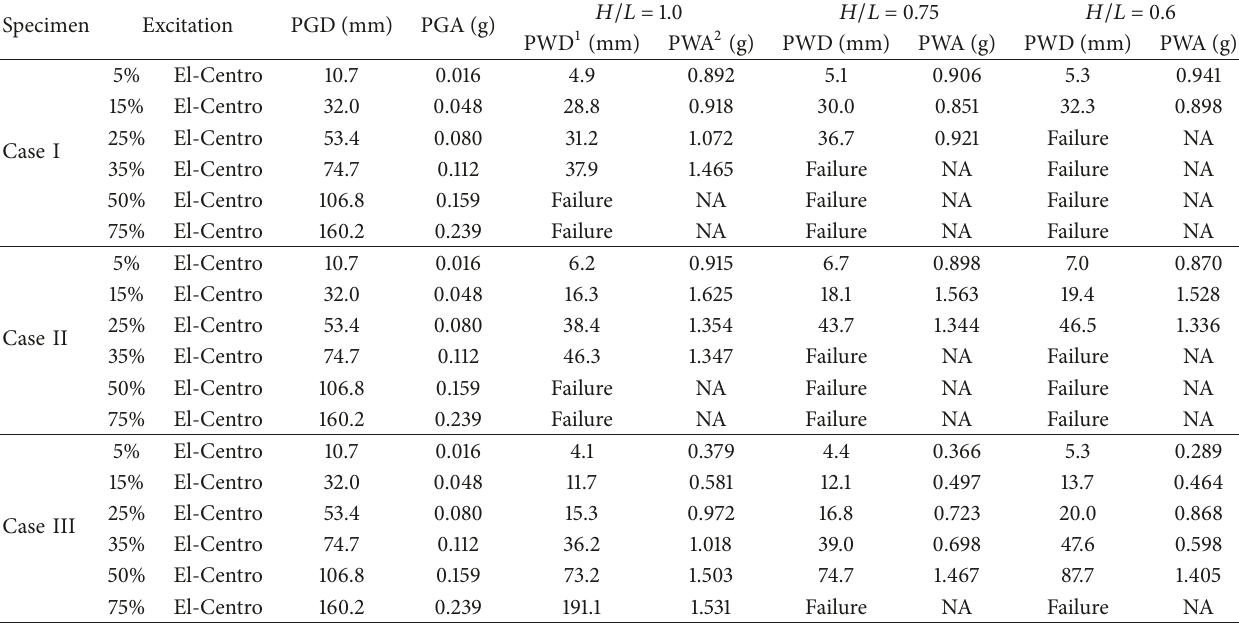
Table 4: Summary of the key IDA results for different infill